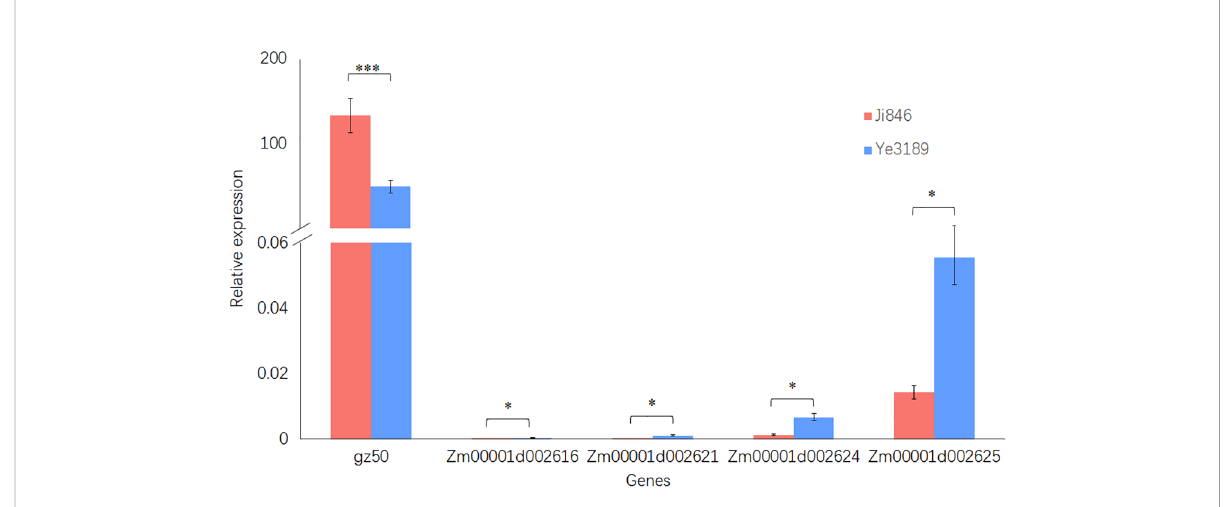
FIGURE 6 Relative quantitative expression analysis of Zm00001d002625 in the endosperm (20 DAP) of Ji846 and Ye3189 using qRT-PCR. The red bars represent Ji846 (high-protein parent), and the blue bars represent Ye3189 (low-protein parent). The horizontal axis of the graph indicates the different genes, and the vertical axis indicates the relative expression levels. The data are presented as the means of three biological and technical replicates ± standard errors. * and *** indicate P< 0.05 and P< 0.001, respectively, by a